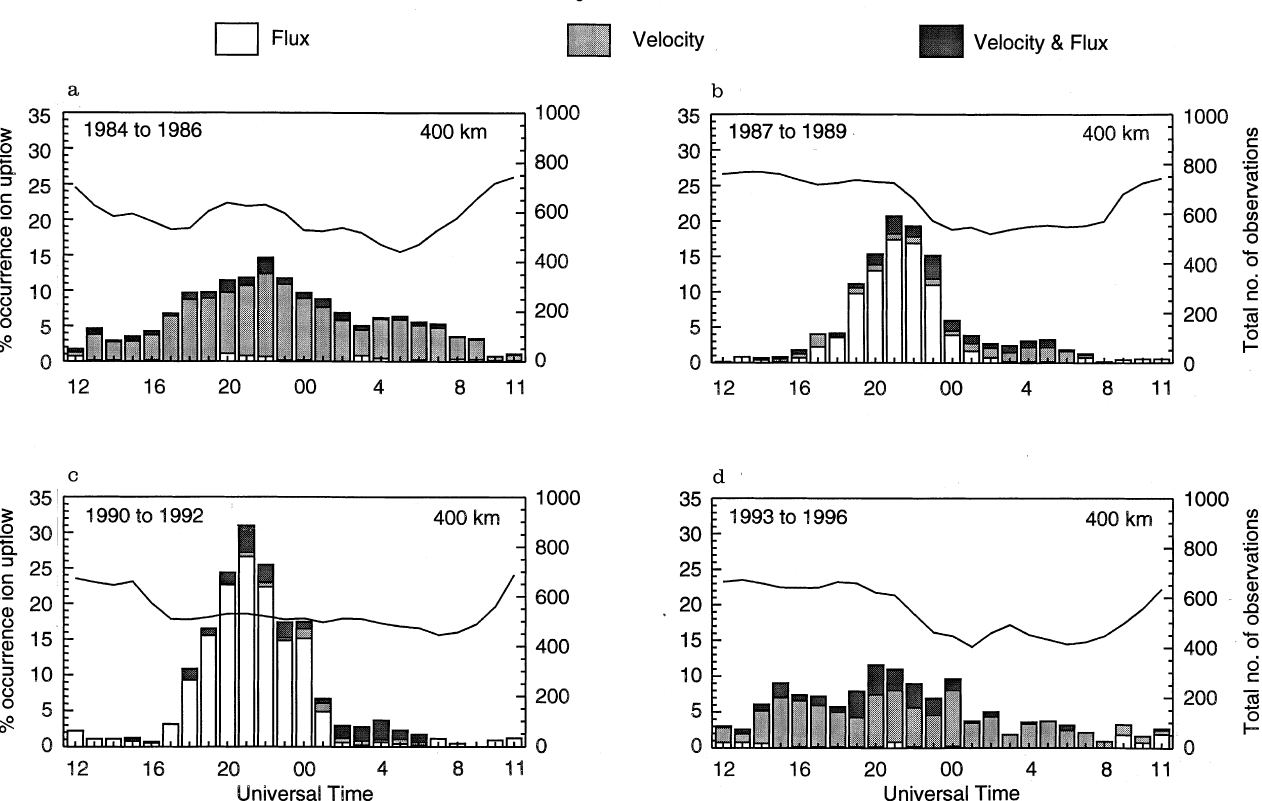
Fig. 6a–d. Same as Fig. 1 but with observations further divided into four three-year bins, illustrating the variation in the diurnal upflow occurrence distribution over one solar